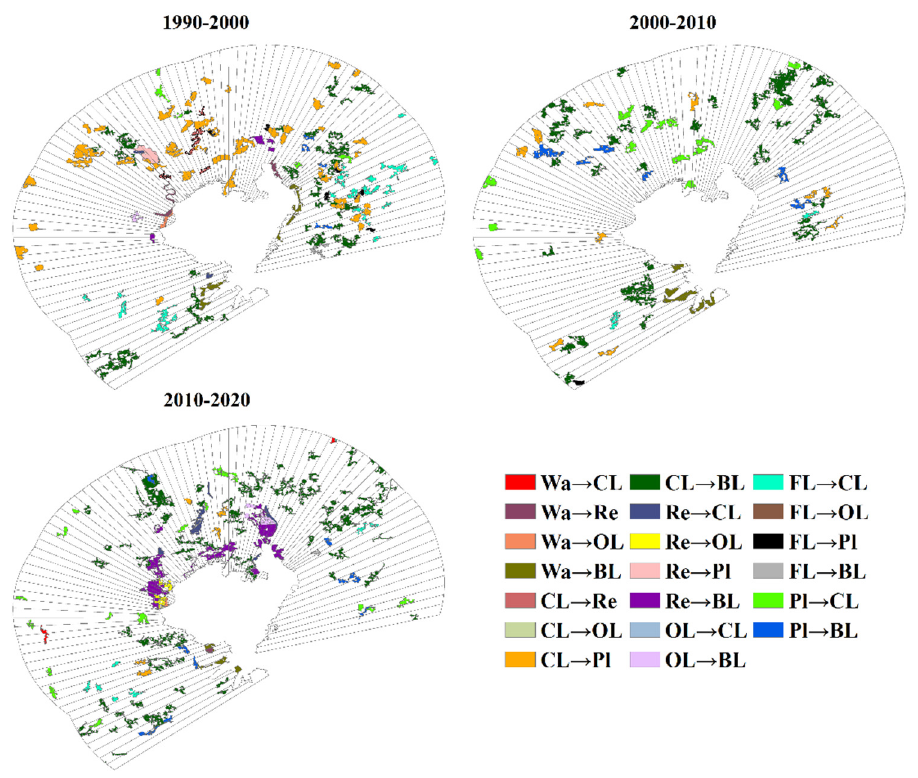
Figure 4. Schematic diagram of the LUT sequence samples in the Qingdao coastal zone (BL: building land; Wa: waters; CL: cultivated land; GP: garden plot; FL: forestland; OL: other land; AS: aquaculture and salt field).